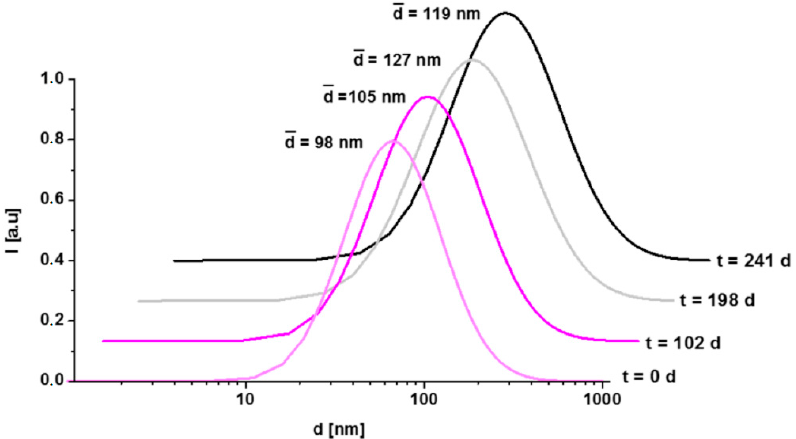
Figure 2. Intensity-weighted log-normal distribution of the hydrodynamic diameter of polyR-Fe 3 O 4 at different time points after synthesis. The mean hydrodynamic diameter 𝑑̅ is displayed for comparison.